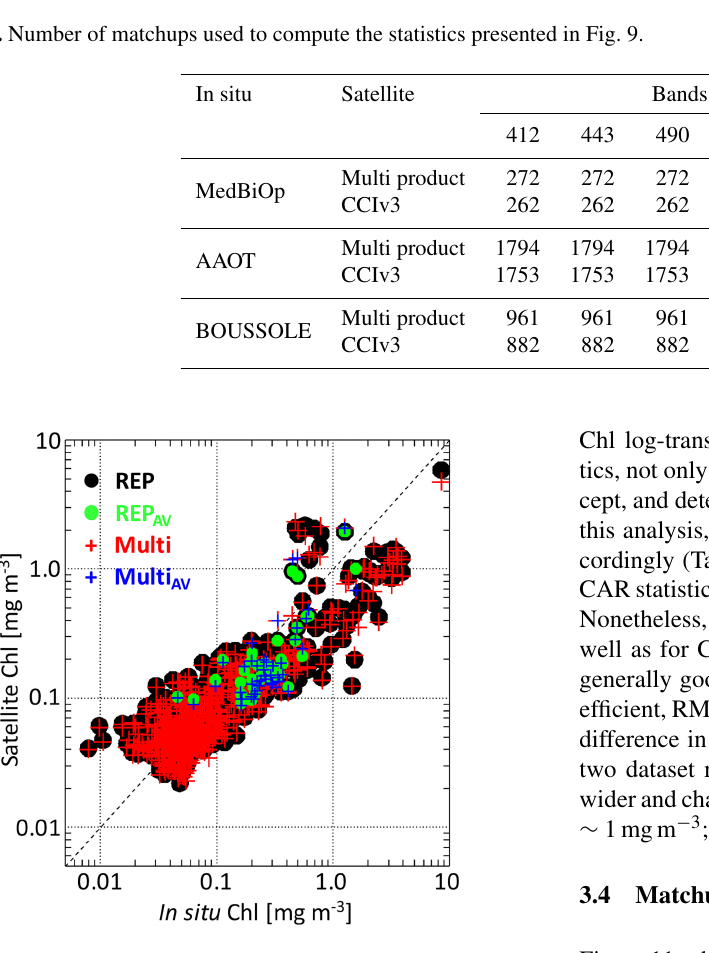
Figure 10. Satellite ( y axis) versus in situ (MedBiOp) Chl concen- tration. Satellite Chl is the REP (derived by the application of the MedOC4.2018 to the Rrs derived from the CCIv3 processor, black) and NRT–DT (derived from the multi-processing, red). Green dots and blue crosses are the REP and NRT–DT for matchups on the pe- riod in which VIIRS and MODIS coexist (REP AV and Multi AV ). Statistics associated with the matchup comparison are shown in Ta- ble